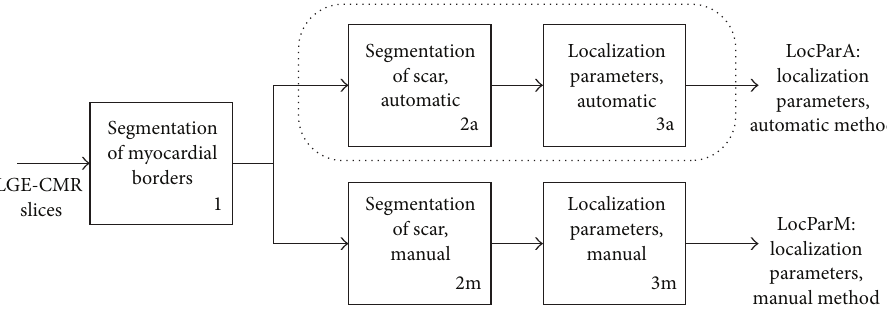
Figure 1: The dotted line including box 2a and box 3a illustrates the automatic method for finding localization parameters for the myocardial scar, and the output is named LocParA (Localization Parameters Automatic). Box 2a represents the 3DmaxSI method from [14], which corresponds to the Full-Width-Half-Maximum (FWHM) criterion. Box 3a corresponds to the automatic localization parameter algorithm, first described by the authors in [13]. 2m and 3m correspond to manual demarking of the scar followed by a manual interpretation of the localization of the scar according to the AHA standard of 17 segments and the transmurality. The result is named LocParM (Localization Parameters Manual). In this paper, the findings of LocParA and LocParM are both compared to knowledge about which artery caused the infarction in the different patients.